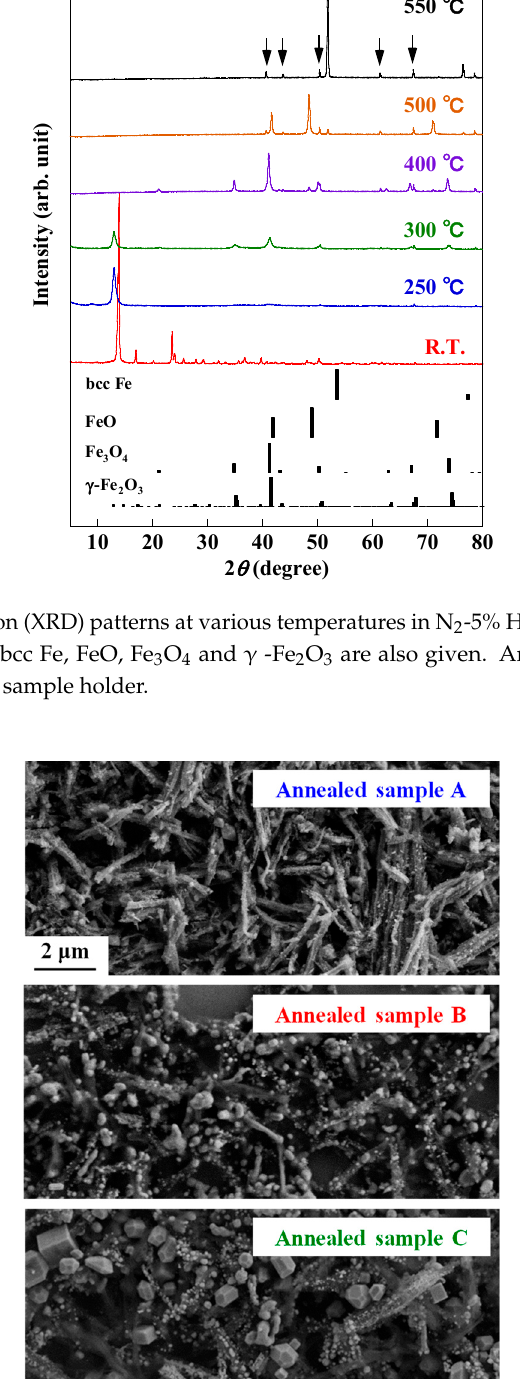
Figure 3. SEM images of annealed samples A, B and C. (the scale is the same for the 3 images)